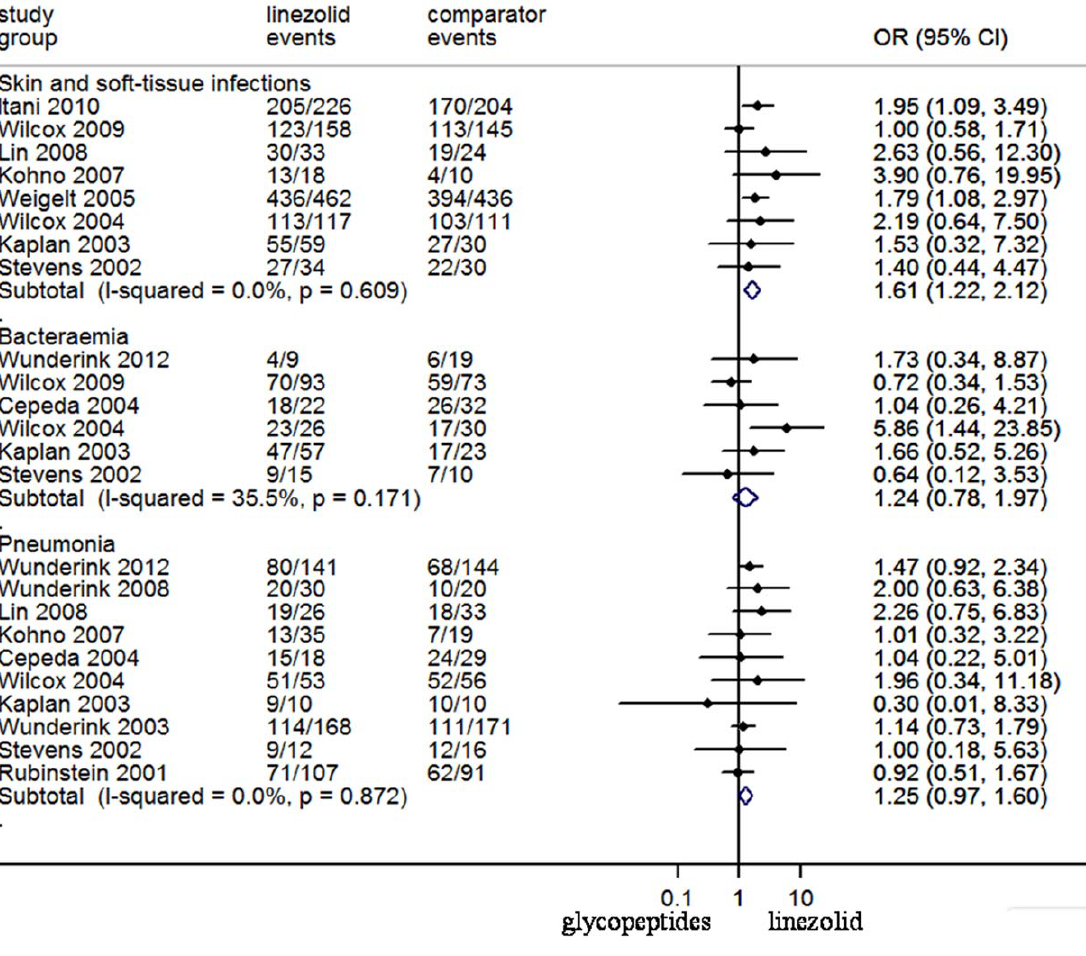
Figure 3. Meta-analyses of treatment success for clinically assessed patients with skin and soft-tissue infections, bacteraemia, and pneumonia. Test of SSTI for overall effect: Z=3.37 P =0.001; test of bacteraemia for overall effect: Z=0.91 P =0.364; test of pneumonia for overall effect: Z=1.73 P =.083.